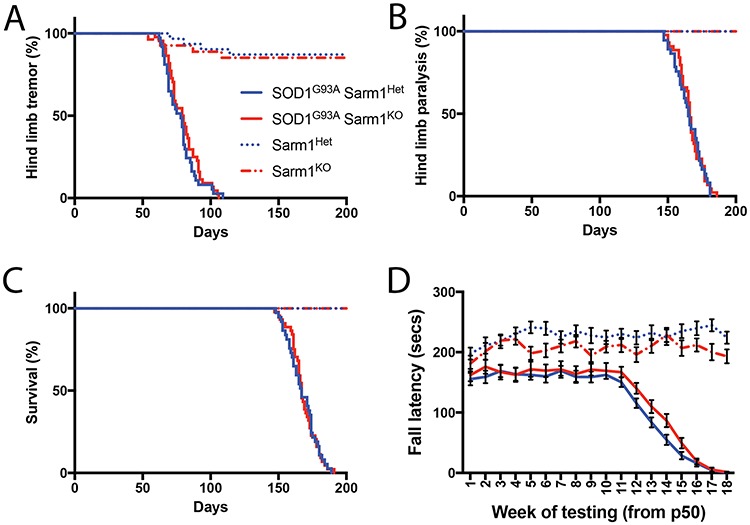
Sarm1 does not contribute to onset, survival or sensorimotor performance deficits in SOD1G93A mice. Percentage of transgenic colony free of (A) hind limb tremor and (B) hind limb paralysis. (C) Kaplan–Meyer plot showing survival of transgenic cohorts (A–C: Sarm1Het SOD1G93A, n = 37; Sarm1KO SOD1G93A, n = 44; Sarm1Het control, n = 31; Sarm1KO control, n = 27; Sarm1Het SOD1G93A vs Sarm1KO SOD1G93A; Log-Rank test, P-value > 0.05). (D) Fall latency of male transgenic mice on 4–40 rpm accelerating rotarod task for assessment of sensorimotor function (SOD1G93A groups, n = 20; control groups, n = 15; two-way ANOVA with Bonferonni post-hoc test).